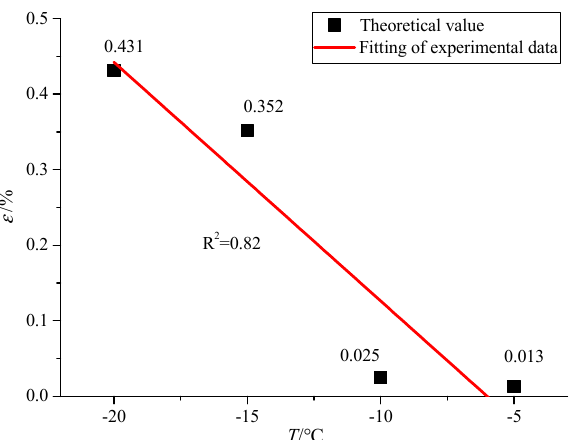
Figure 16. The relationship between the maximum generalized strain at the crack tip and the external temperature ( T ).